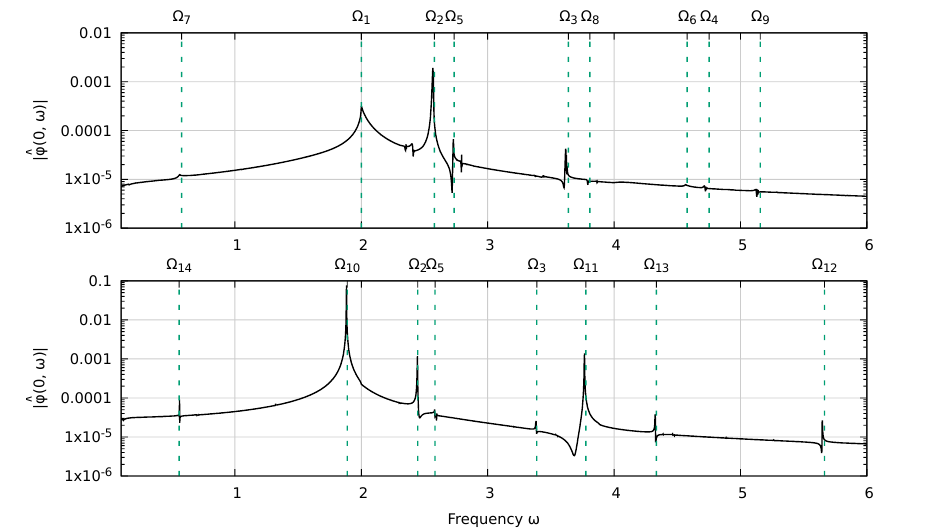
Figure 6 . Power spectra at the boundary after a collision with v i = 0 : 5, for H = (cid:0) 0 : 1 (upper) and H = 0 : 3